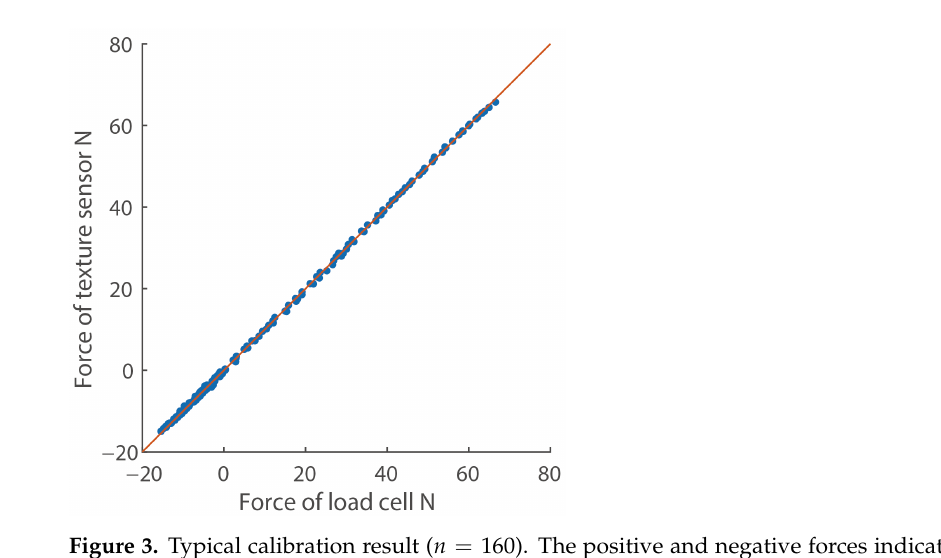
Figure 3. Typical calibration result ( n = 160). The positive and negative forces indicate the force during pushing and pulling, respectively. The red line shows the approximation line.